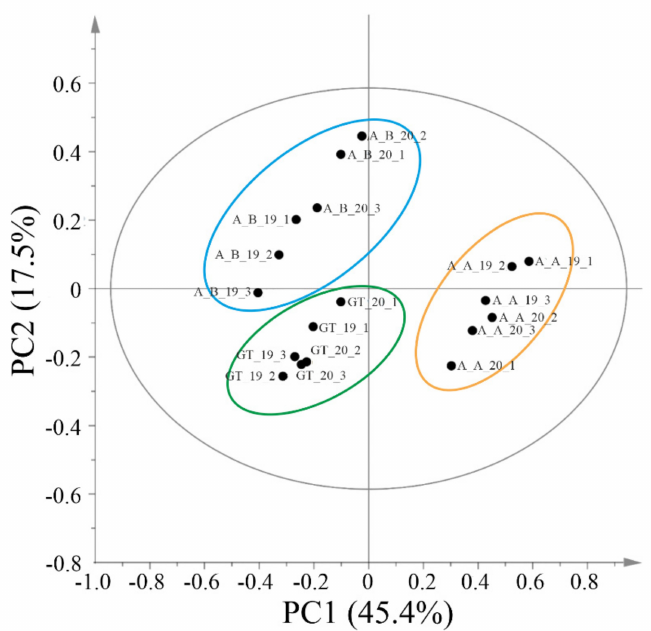
Figure 3. Score scatter plot of PC1 versus PC2 obtained from the PCA of NMR data. The el- lipse represents the Hotelling T2 with 95% confidence. A_A = ‘Asprinio_A’; A_B = ‘Asprinio_B’; GT = ‘Greco di Tufo’. The vintage is indicated by the numbers 19 (for 2019) and 20 (for